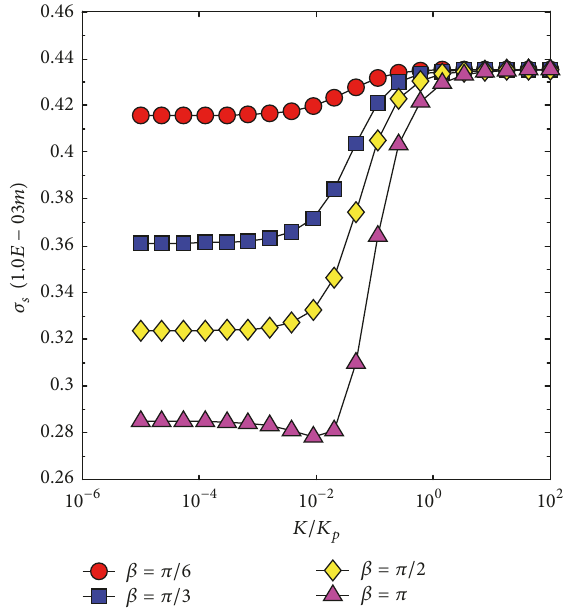
Figure 7: Influence of stiffness 𝐾 on the 𝜎 𝑠 at 𝑘 𝑚 𝑎 = 3.0 under several 𝛽